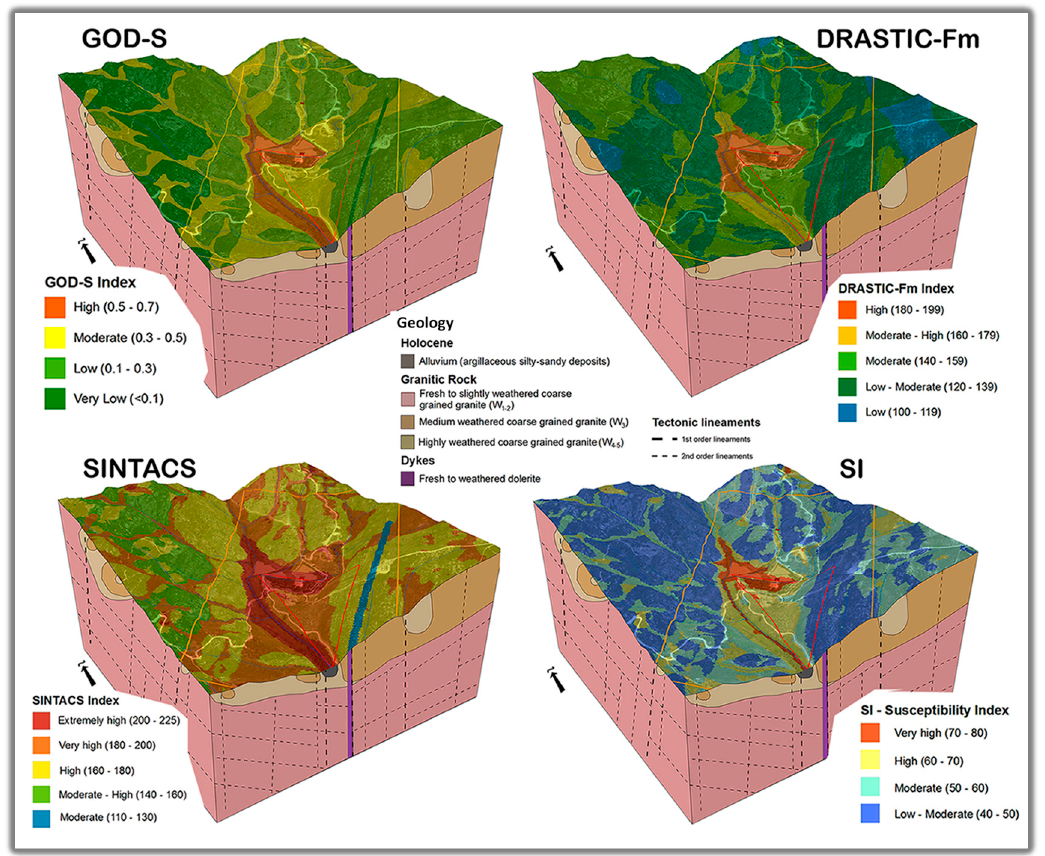
Figure 6. Ground conditions and intrinsic vulnerability indexes mapping: GOD-S, DRASTIC-Fm, SINTACS, SI.